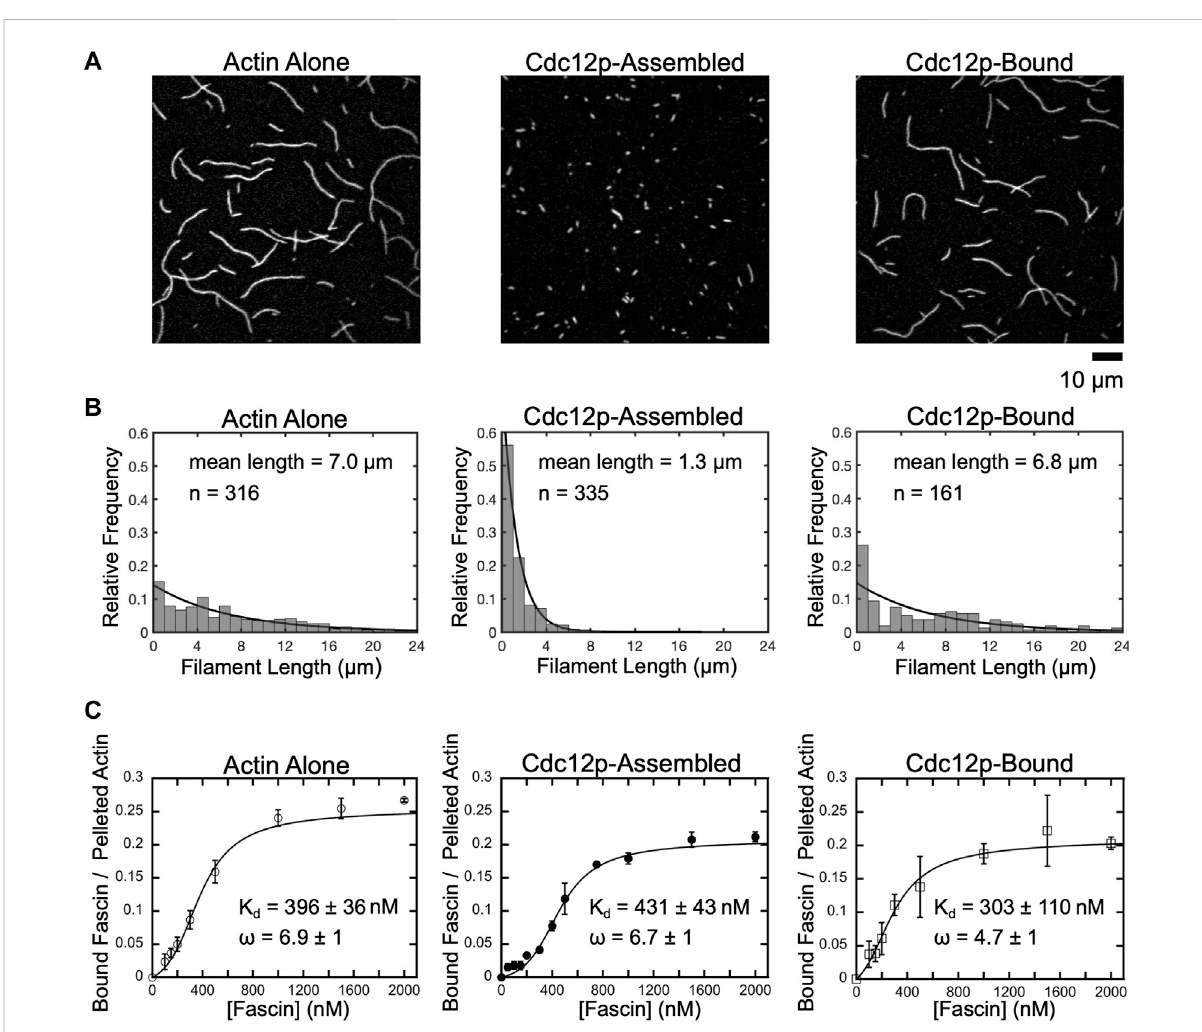
FIGURE 1 Fascin binds with similar af fi nity to short and long fi laments. (A) Representative micrographs of fi laments polymerized from 2 µM actin monomers in the absence or presence of 250 nM Cdc12p. Filaments were labeled with FITC-phalloidin, diluted in imaging buffer and visualized by TIRF microscopy. Cdc12p was added prior to polymerization in the “ Cdc12p-Assembled ” sample and post-polymerization in the “ Cdc12p-Bound ” sample. (B) Histograms of fi lament lengths measured at equilibrium for reactions polymerized in different conditions. The lines are fi ts to the datausingtheexponentialequation f i = λ exp(- λ li).The fi ttedvaluesfor λ are0.143,0.769 and0.147,andthemean fi lamentlengthsare1/ λ ,or7.0, 1.3, and 6.8 µm for fi laments assembled in reactions containing actin alone (left), fi laments assembled in the presence of Cdc12p (middle), and fi laments bound by Cdc12p following polymerization, respectively. (C) Co-sedimentation assays measuring fascin binding to actin bundles assembled from short and long fi laments. Filaments were assembled in the absence or presence of Cdc12p and incubated with a range of fascin concentrations. Reactions were spun at low-speed (10,000 x g or 20,000 x g for long or short fi laments, respectively) to pellet bundles and analyzed by SDS-PAGE. The intensity of the fascin band in the pelleted fraction was divided by the intensity of the actin band in the pelleted (i.e., bundled) fraction for each reaction. Lines are fi ts of the McGhee-von Hippel cooperative binding model, which yields a binding af fi nity (K d ) and cooperativity constant ( ω ) (McGhee and von Hippel, 1974; De La Cruz, 2005). Error bars are the standard error of the mean values obtained from at least three independent